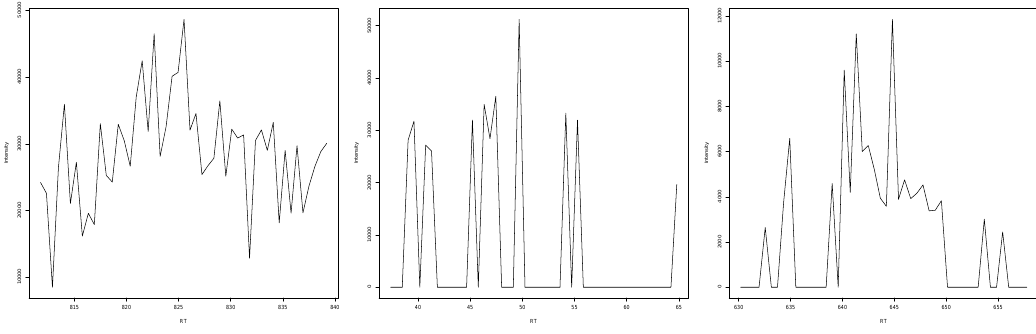
Figure A7. Three examples of EICs that were classified as "not peaks" by all experts.